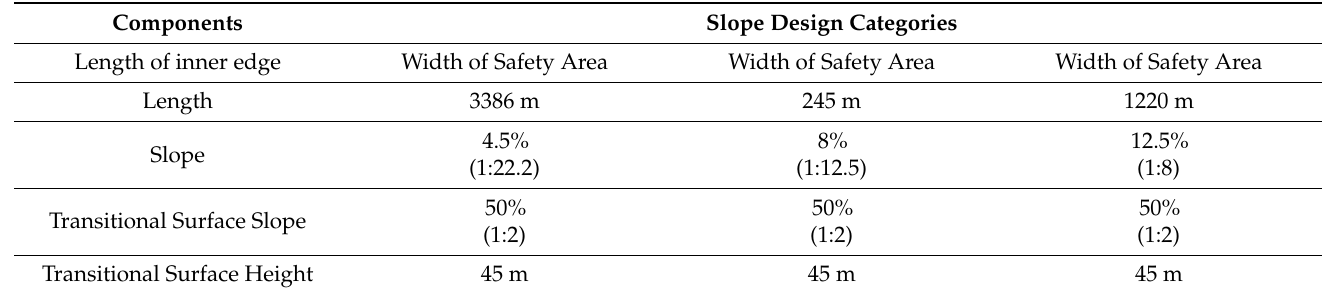
Table 4. Dimensions and slope of obstacle limitation surfaces for all visual FATOs [15].